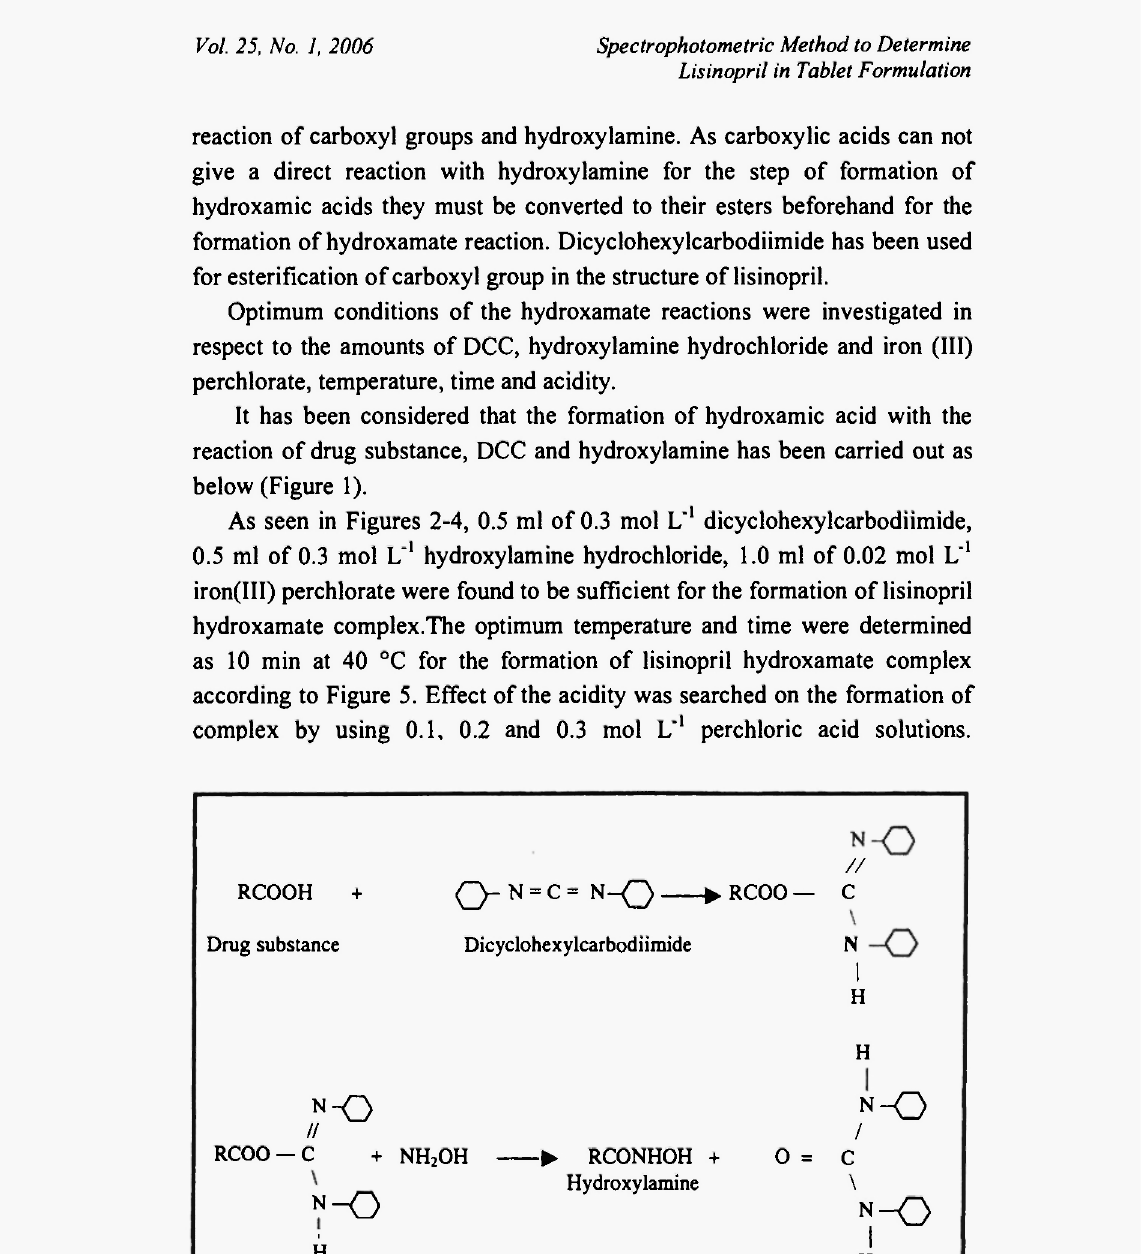
Fig. 1: The equations of reaction on the formation of lisinopril hydroxamate